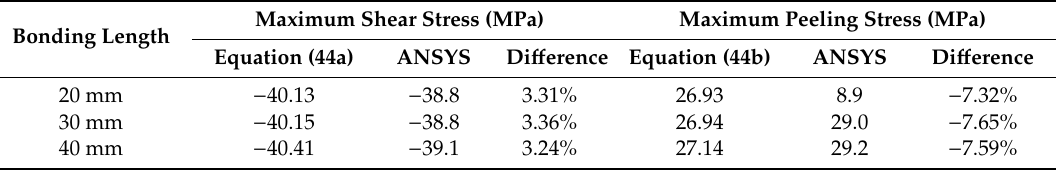
Table 5. Comparison of maximum interfacial stresses with different bonding length obtained by Equation (44) and ANSYS.